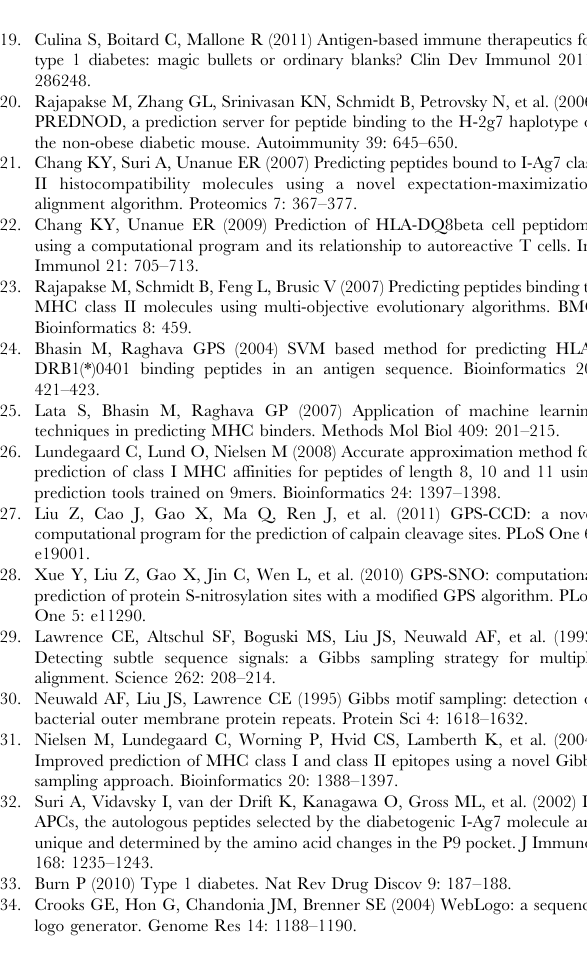
Table S2 The core nonamers of the human HLA-DQ8 epitopes. Table S3 From the scientific literature, we collected 203 epitopes in 25 proteins, with 70 MHC class I epitopes,